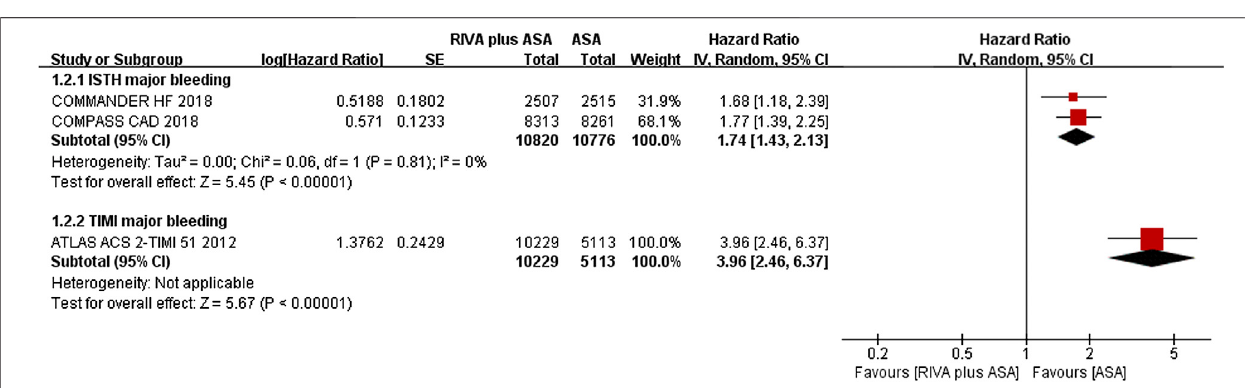
Frontiers in Pharmacology |